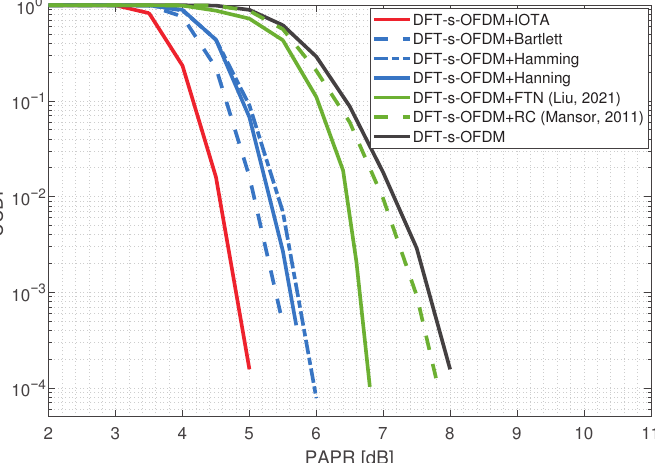
Figure 16. Effect of FDSS on PAPR performance, including the results of FTN [26] and RC [27].